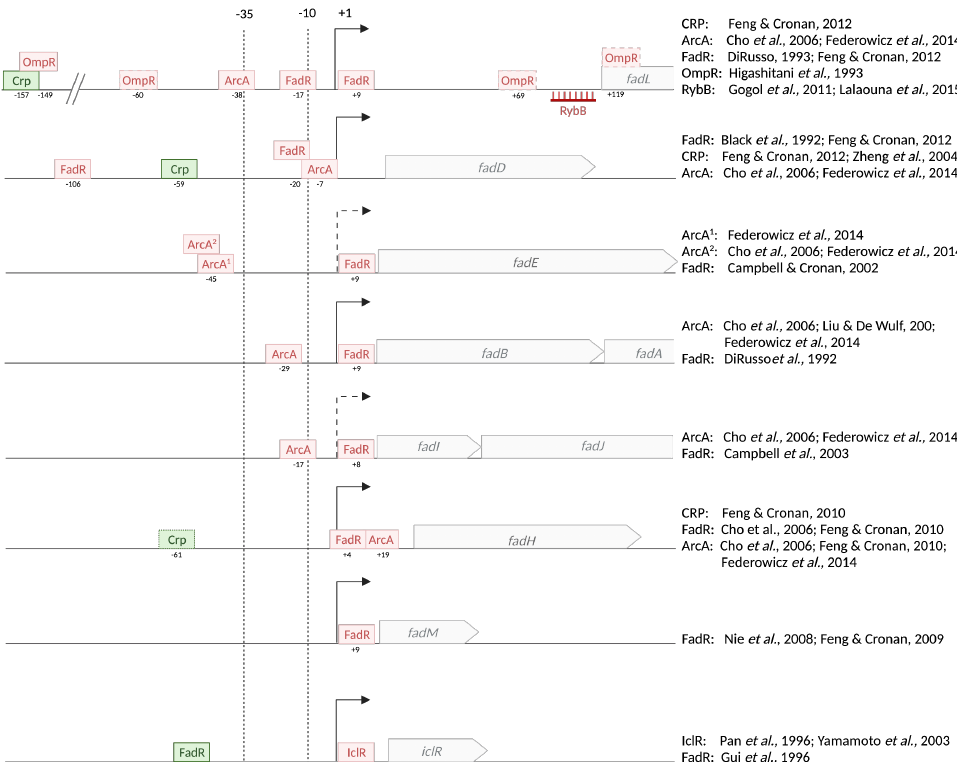
Figure 9. Position of the transcriptional regulator binding sites in fad promoters. The promoter transcription start sites are indicated by arrows (+1). The − 10 and − 35 regions are aligned and marked by the dotted vertical lines. The dashed arrows for fadIJ and fadE indicate the prediction from whole-genome determination of transcription start sites [65]. The other transcription start sites were determined as described in the references indicated below. The position of each binding site is marked by boxes with the name of the corresponding transcriptional regulator. The distance of the middle of each binding box to the transcription start site is given below the box. The repressors are shown in red, and the activators of gene expression in green. The position of hybridization of the sRNA RybB on FadL mRNA is also indicated. The references for specific studies of the expression of the indicated gene are the following: fadL : [66–72]; fadD : [67–69,73–75]; fadE : [19,68,69]; fadBA : [68,69,76,77]; fadIJ : [51,68,69,78]; fadH : [68,69,79]; fadM : [37,39]; iclR :